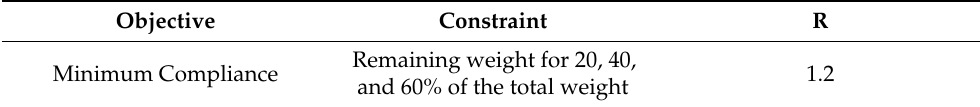
Figure 2. Problems defined in the MATLAB code. Table 3. Optimization parameters in this research